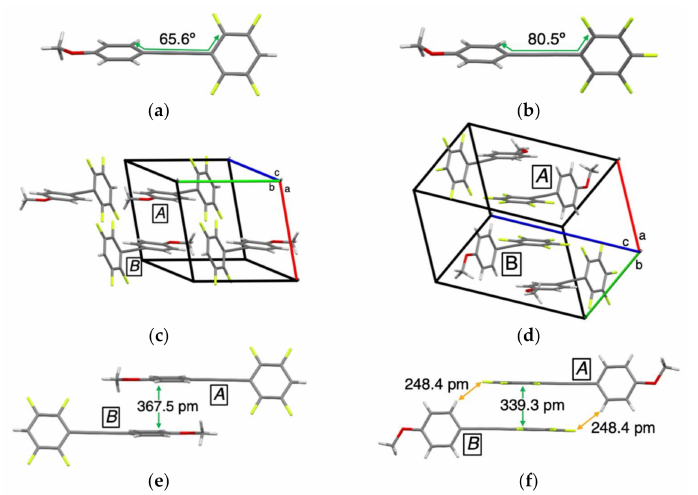
Figure 6. Crystal structures of ( a ) 4F , ( b ) 5F , packing structures of ( c ) 4F , ( d ) 5F , and intermolecular interactions of ( e ) 4F , ( f ) 5F